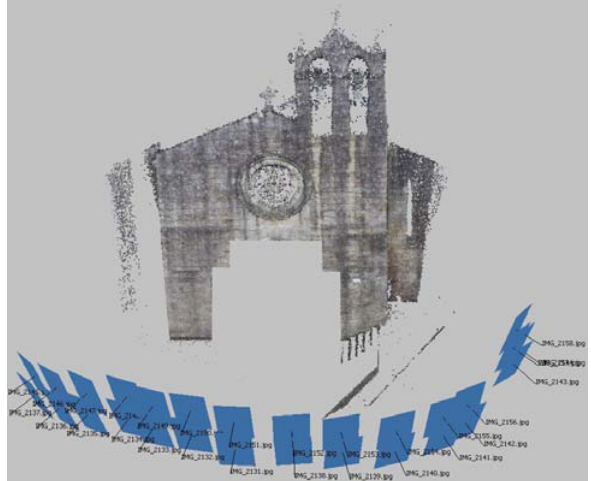
Figure 3. Sparse point cloud of the general façade (doorway zone excluded) with all the shootings needed: 14 tripod placements, two photo from each placement, so 28 images.